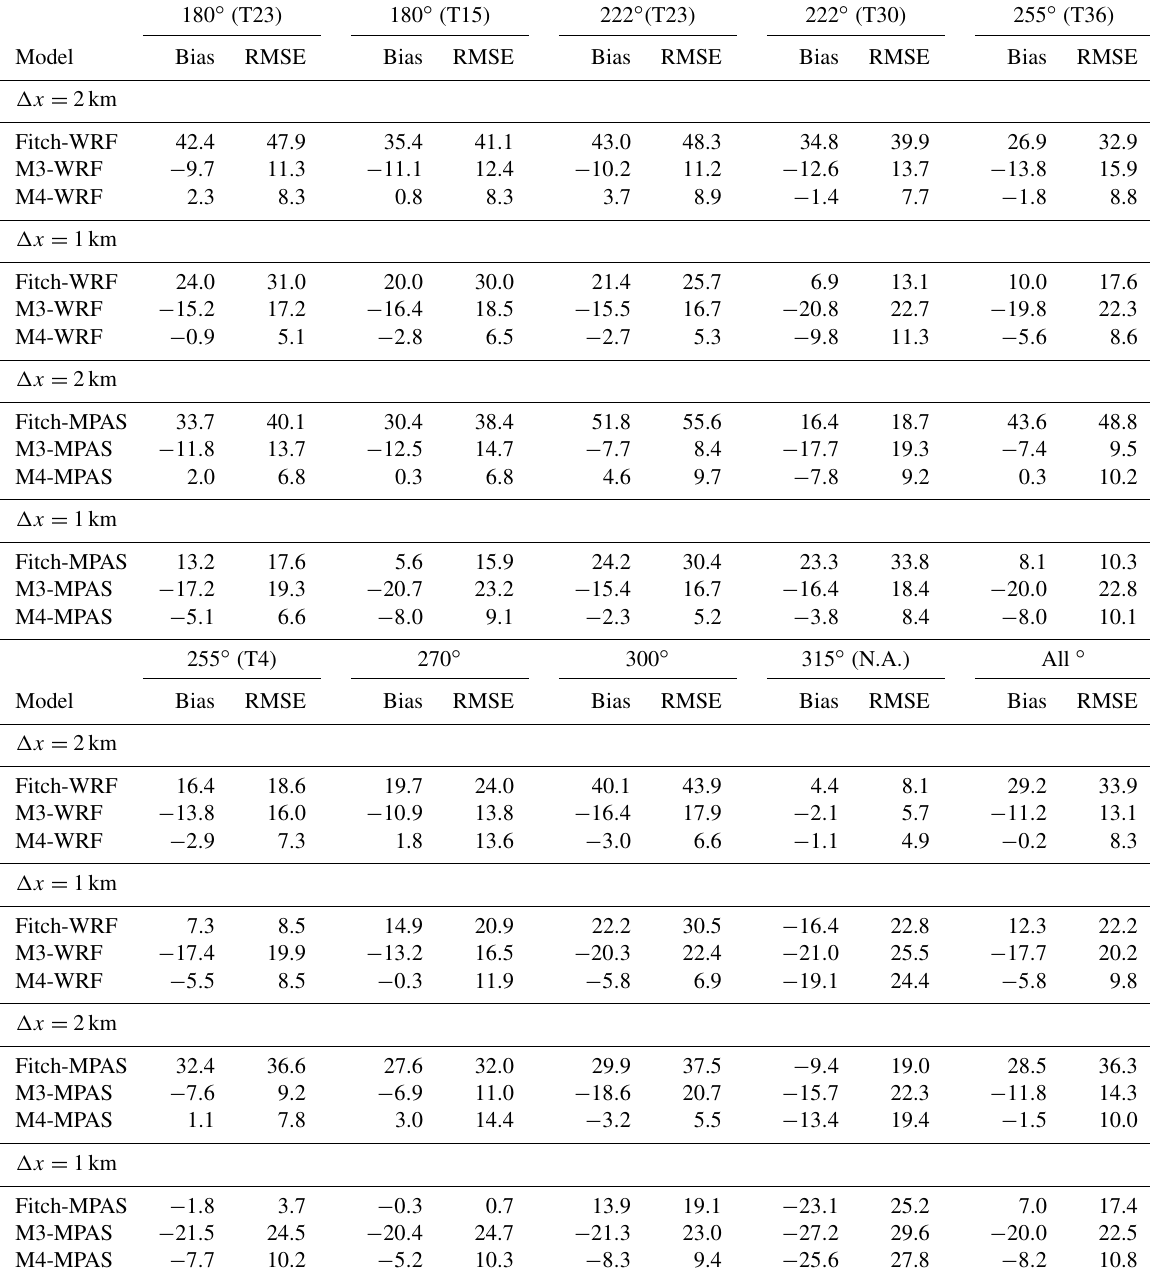
Table 3. As in Table 1 but at Lillgrund for multi-cell cases (in percent). The results are from WRF and